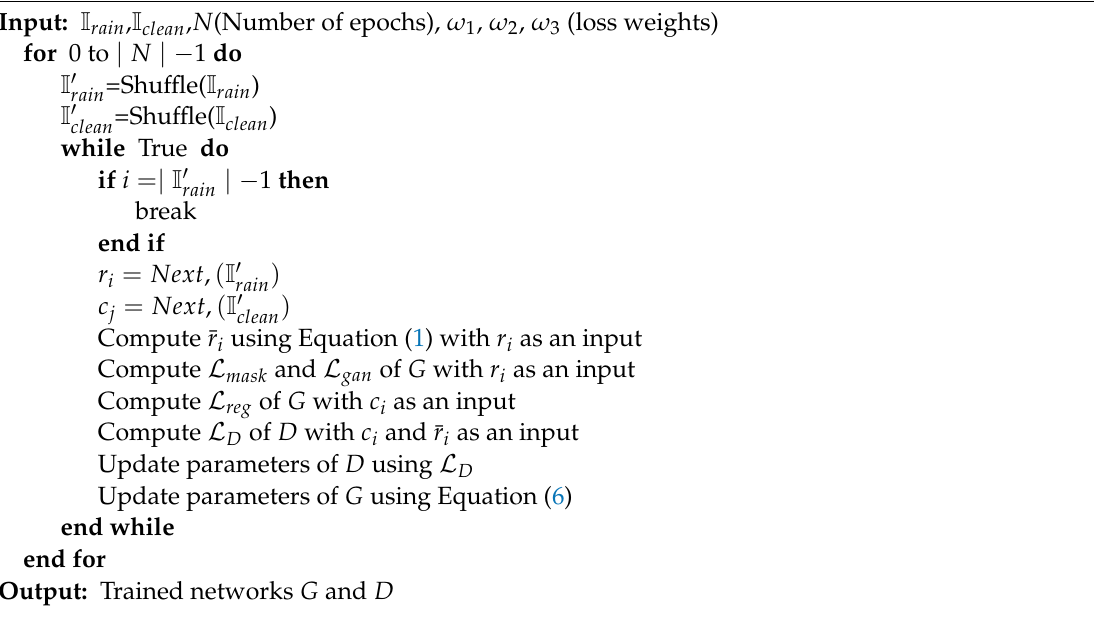
Algorithm 1 Unsupervised training procedure for the Raindrop-aware